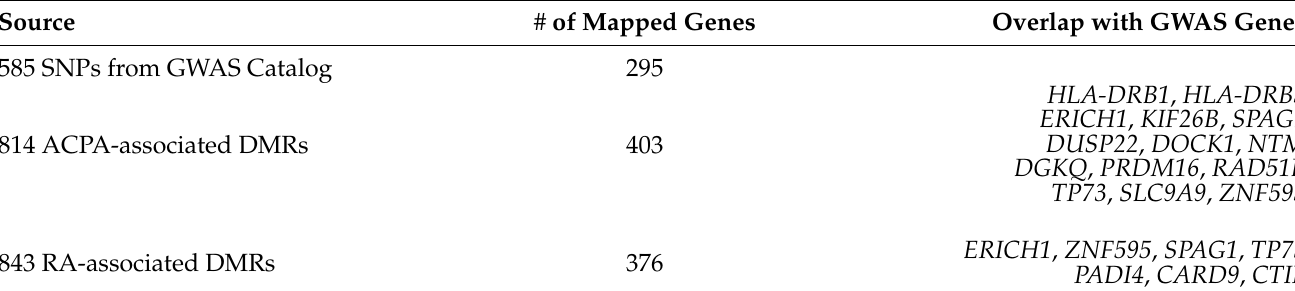
Table 5. Summary of protein-coding genes associated with identified ACPA and RA DMRs, and those associated with RA causal SNPs from GWAS